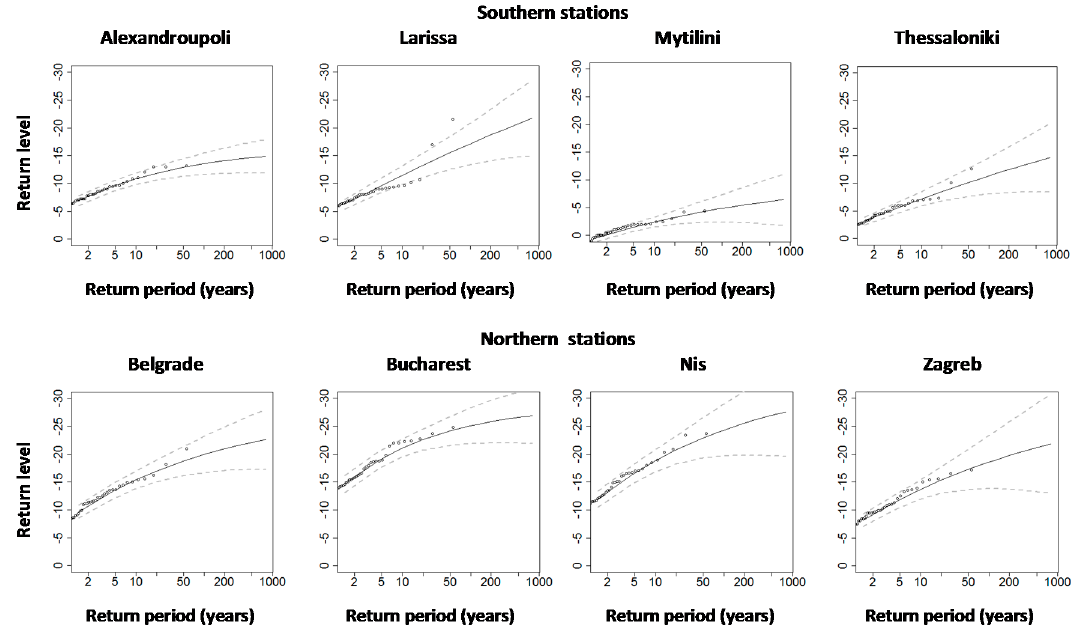
Figure 4. The return levels curves for the eight stations with the 95% confidence interval (dashed line).